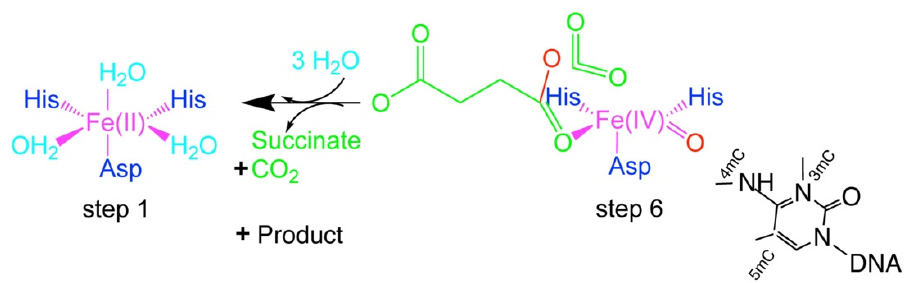
Figure 7. Representation of the proximity of the methyl group at 3, 4, 5 positions to the highly reactive Fe IV-oxo intermediate. Any well-placed C-H bond (3mC, 4mC, 5mC) is likely to be targeted to complete the oxidative cycle following the formation of a highly reactive Fe IV-oxo intermediate.